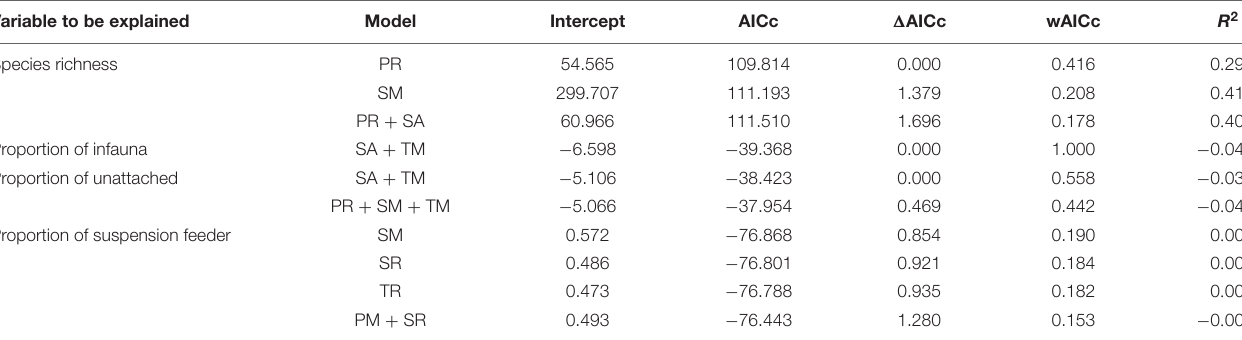
events such as tropical storms can also produce habitat mixing of shallow seafloors (Miller et al., 1992; Bhattacherjee et al., 2021). The small original sample size and severe